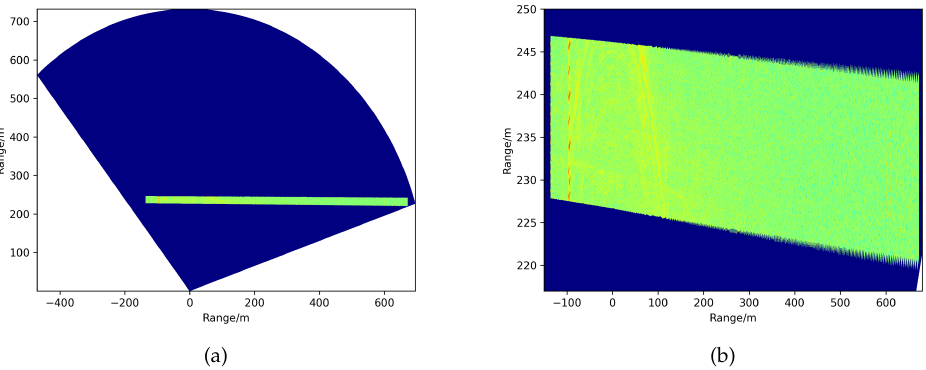
Figure 10. The runway ROI extraction results. ( a ) The extracted main inspection runway in the whole range. ( b ) The local amplification of extracted runway.